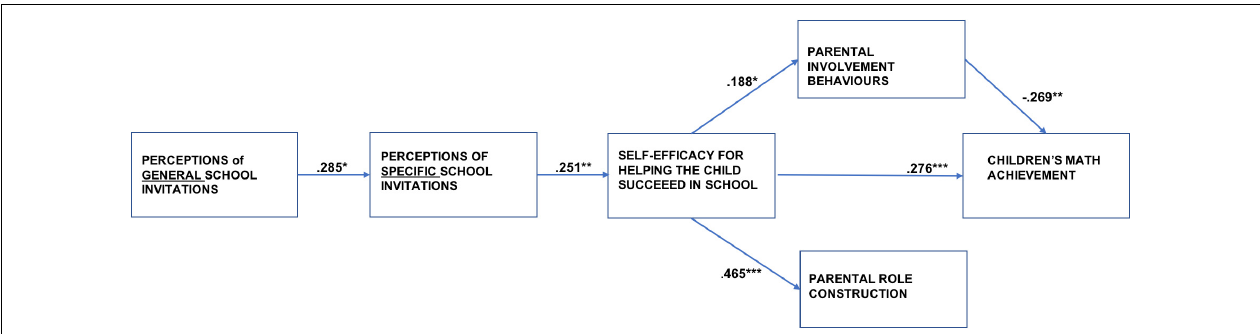
FIGURE 4 | Path model for statistically significant effects of parental involvement factors on children’s mathematics achievement. The direct effects between Role Construction and Involvement Behaviors was tested but not significant. Likewise, the effect between Role Construction and Children’s Math Achievement. * p < 0.05, ** p < 0.01, *** p <